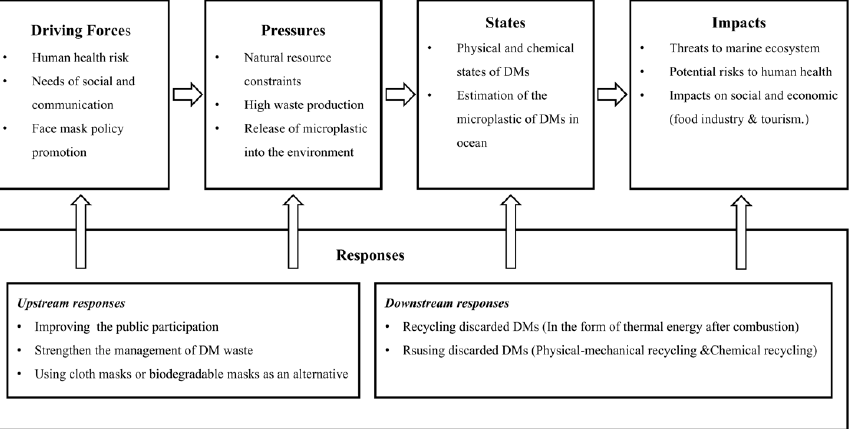
Figure 2. The DPSIR framework for analysis of disposable masks in marine microplastic